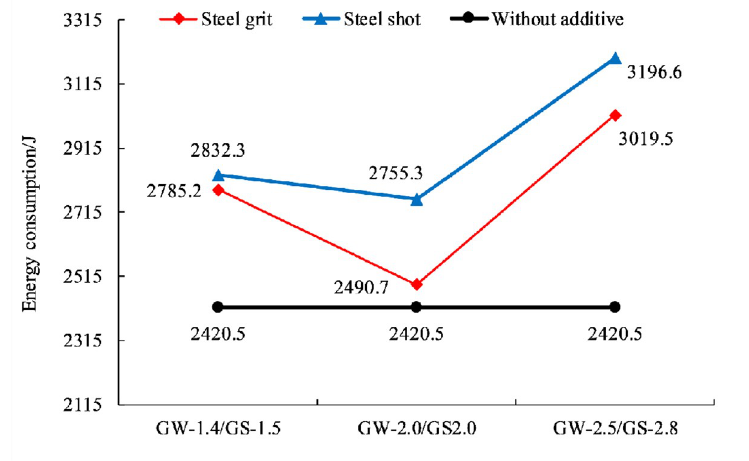
Fig 23. Effect of aggregate shape on energy consumption.